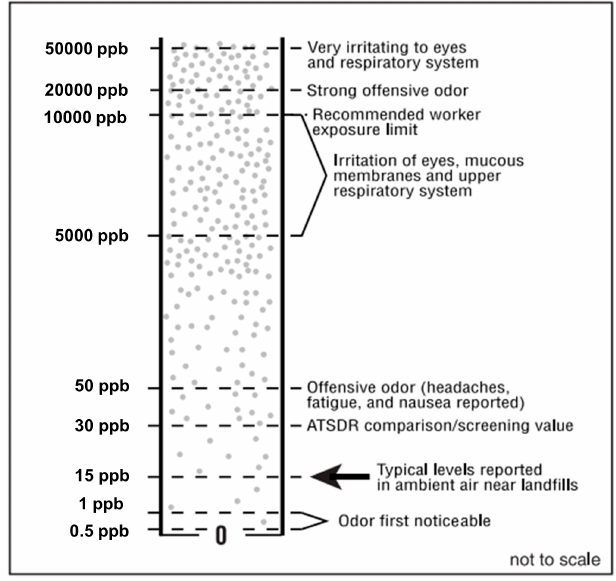
Figure 1. Ambient hydrogen sulfide mixing ratios and corresponding health effects from exposure (source: Centers for Disease Control and Prevention (CDC) Agency for Toxic Substances and Disease Registry (ATSDR) [20]). This material does not constitute its endorsement or recommendation by the U.S. Government, Department of Health and Human Services, or CDC. The material is available on the agency website for no